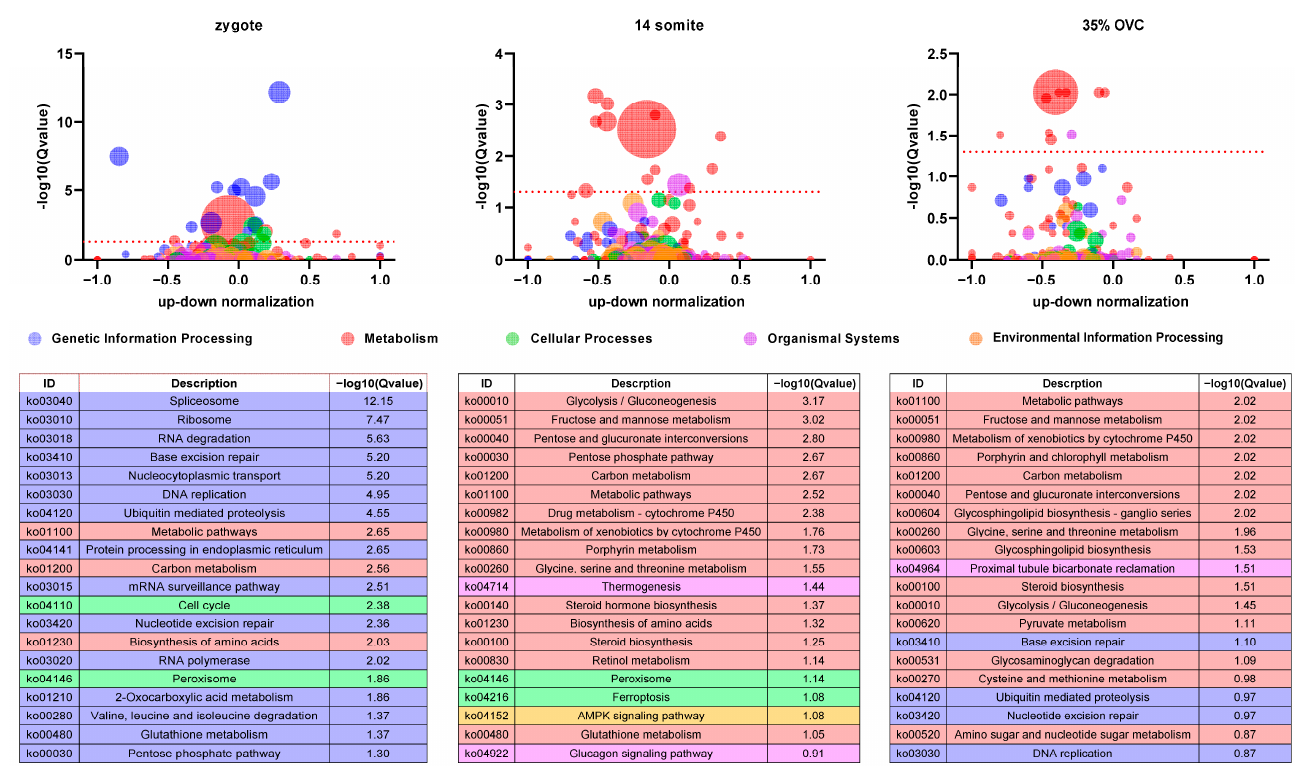
Figure 9. Figure 9. KEGG enrichment analysis of differentially expressed genes between CE and RK goldfish embryos.